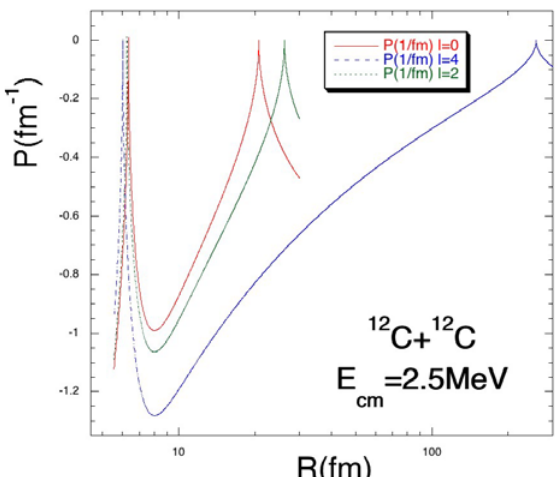
Figure 1. Collective momentum vs distance of the two nuclei for the values of E cm and l indicated. The areas inside the first and second turning points give the action